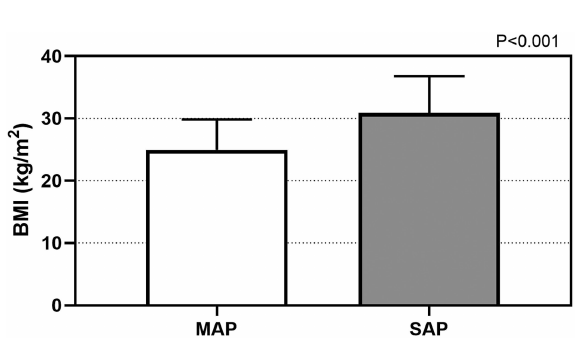
Figure 2. Values of BMI in the MAP and SAP groups. The values of BMI in SAP patients were statistically higher than those in MAP patients. BMI, body mass index; AP, acute pancreatitis; MAP, mild acute pancreatitis; SAP, severe acute